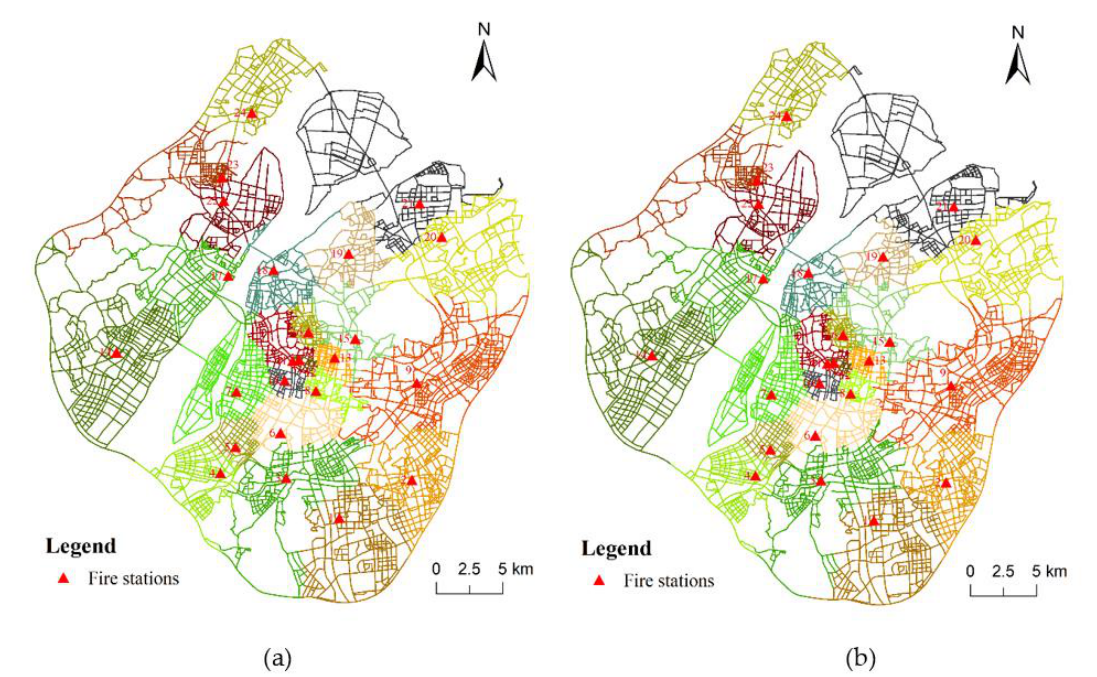
Figure 17. The result of service area delimitation of fire stations using the proposed C-VD with 10-min constraint ( a ) and 15-min constraint ( b ).